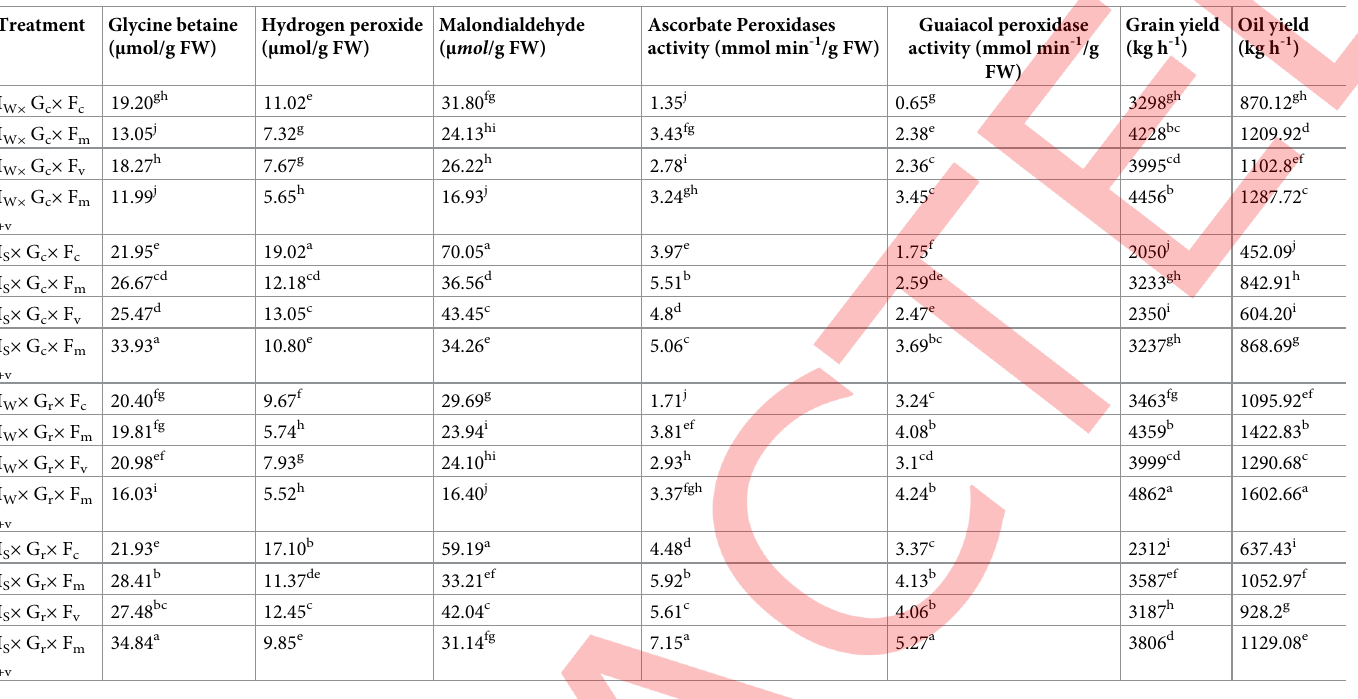
Table 6. Comparison between 2-year mean values of physiological traits of lingrain affected by green manure × mycorrhiza × vermicompost under full and limited irrigation.